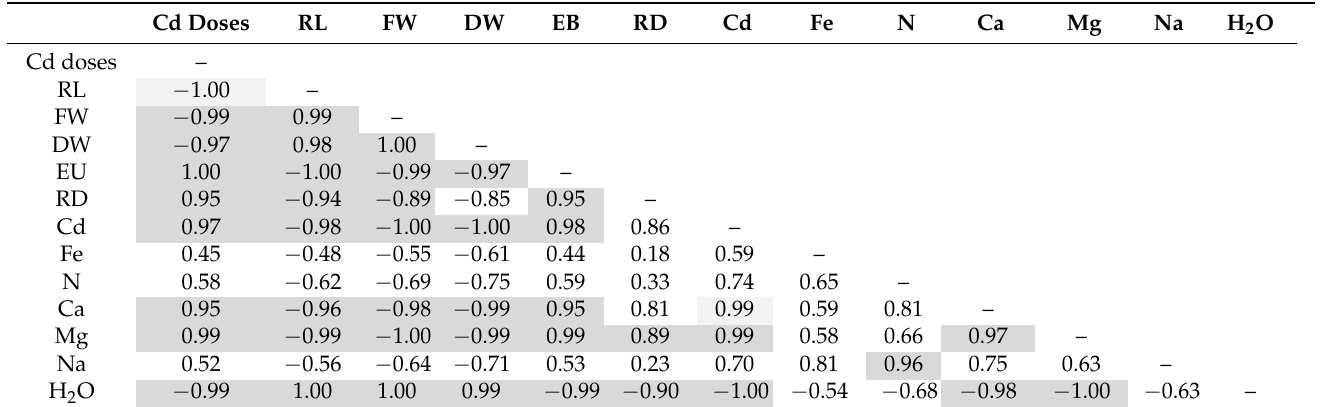
Table 3. Correlation matrix between doses applied, growth parameters, Evans blue uptake, mineral and water content in roots after applying cadmium chloride to the growth